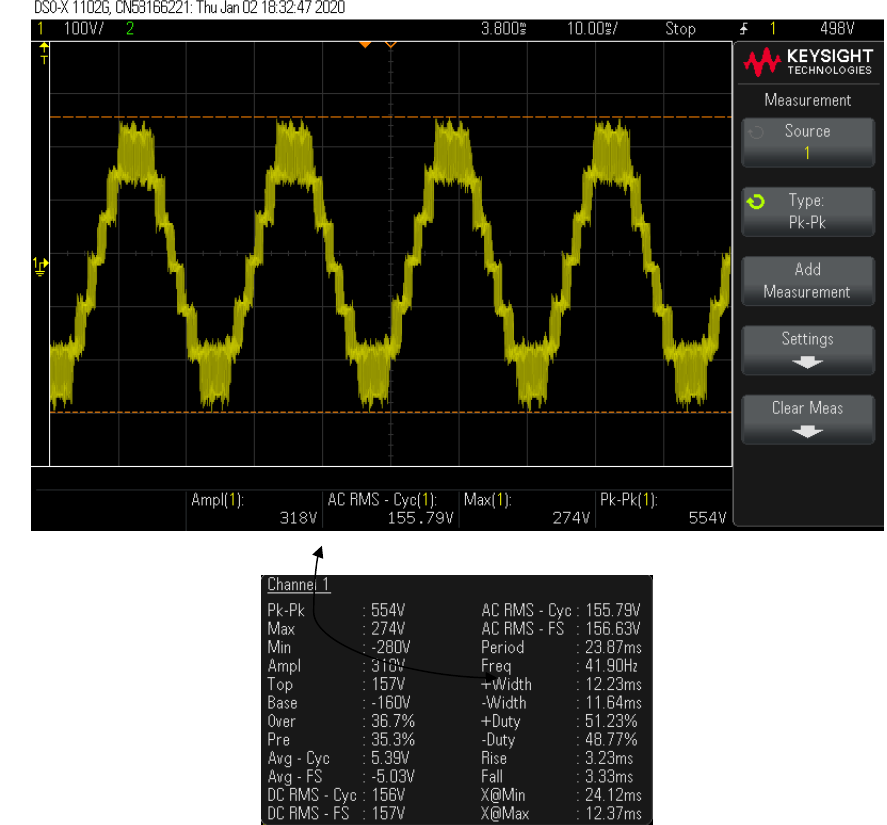
Figure 53. Output voltage waveform under open loop condition.